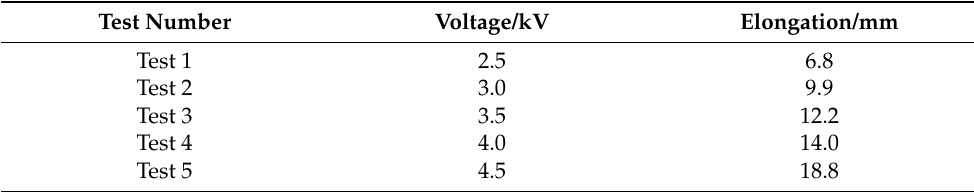
Figure 6. Uniaxial tensile test. Table 4. Elongation at different voltages under static